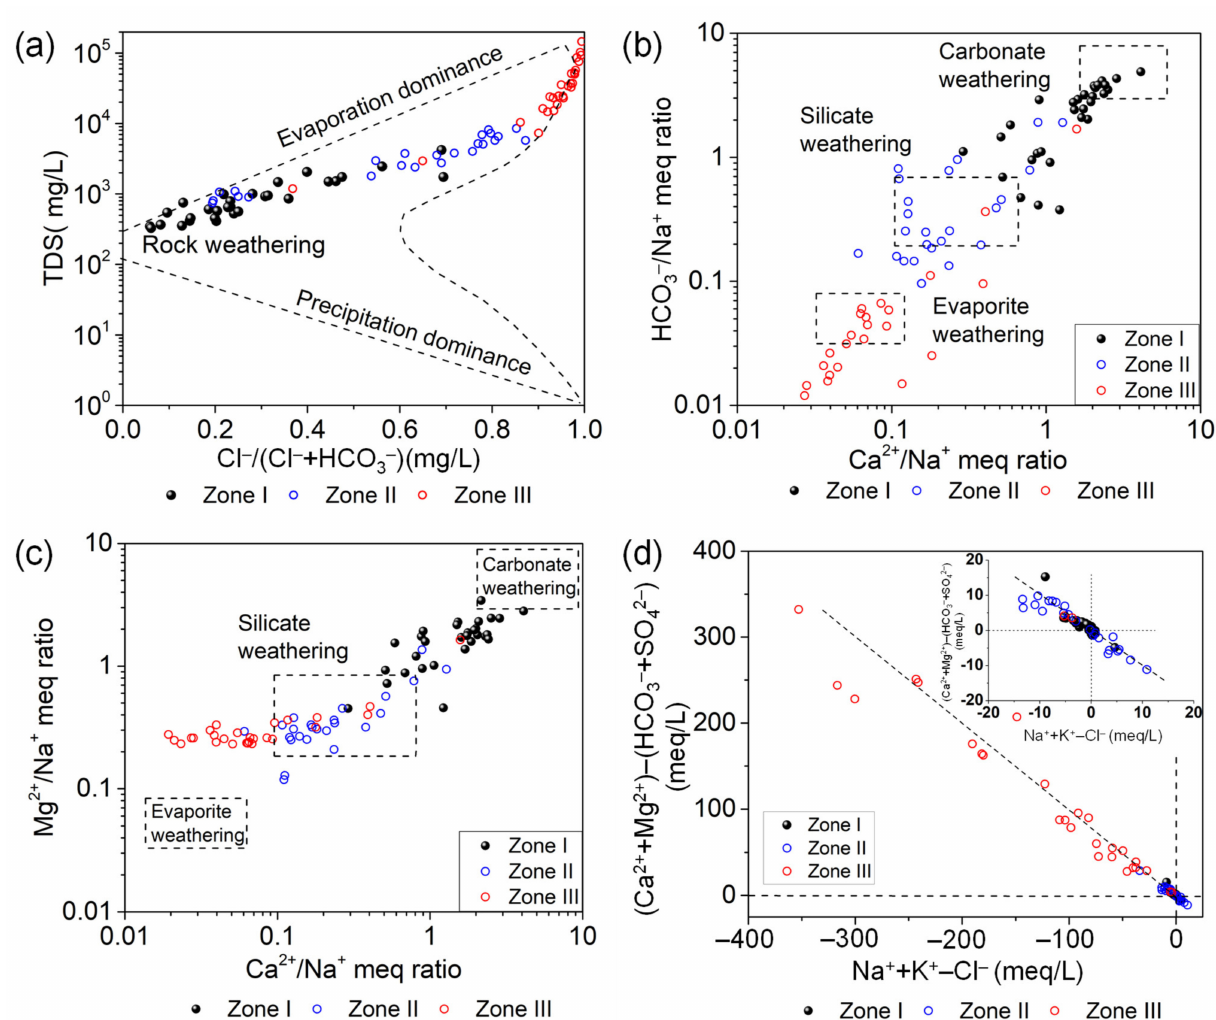
Figure 9. Bivariate plots of TDS versus Cl – /(Cl – +HCO 3– ) ( a ); (Mg 2+ /Na + ) versus (Ca 2+ /Na + ) ( b ); (HCO 3– +Na + ) versus (Ca 2+ +Na + ) ( c ); and (Ca 2+ +Mg 2+ –HCO 3– –SO 42– ) versus (Na + –Cl – ) ( d ) indicate the major hydrochemical processes, wearing, and ionic exchange occurring in